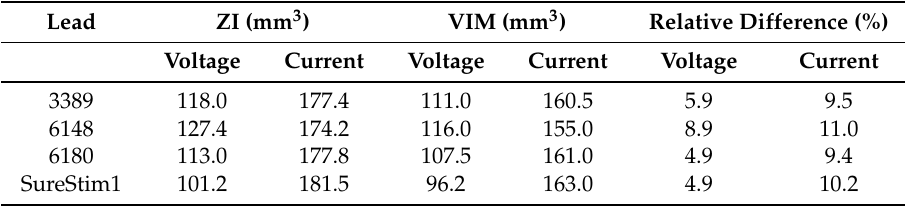
Figure 8. Electric field (EF) simulated at VIM for each lead depicted with an isosurface of 0.2 V/mm. Active contacts (shown in orange in each lead schematic) set to 3 V (first row) and 3.4 mA (bottom row). EF volume within the selected isosurface shown to the right of the lead. A: anterior, P: posterior, S: superior, I: inferior, L: left, R: right. Table 2. Electric field (EF) volume determined by the 0.2 V/mm isosurface achieved by 3 V and 3.4 mA. Relative difference between the targets calculated for each operating mode.